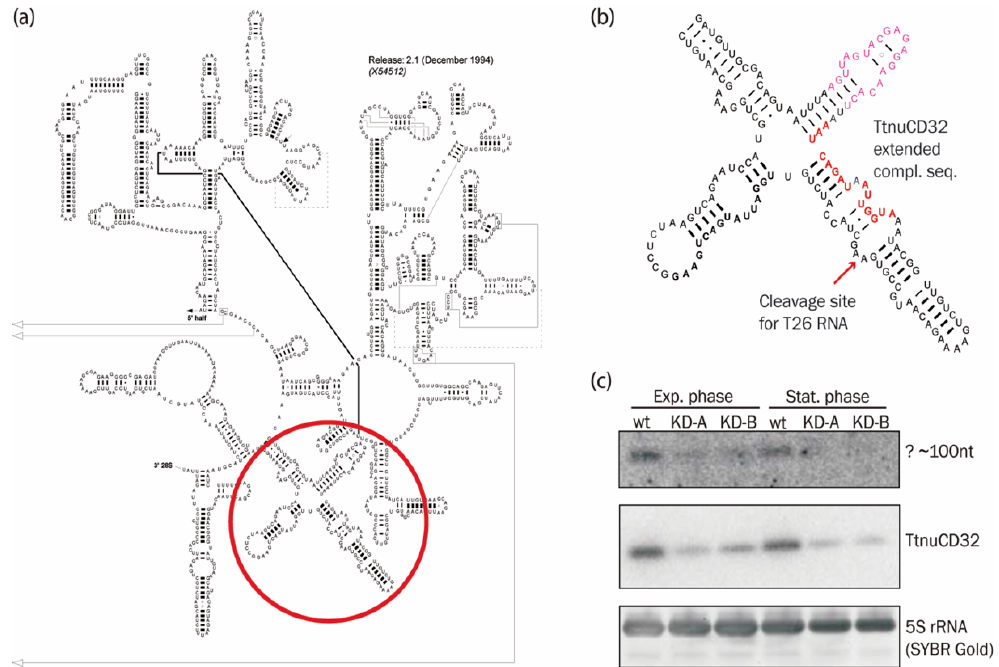
Figure 4. A small rRNA fragment derived from 26S rRNA in the vicinity of a putative non-canonical TtnuCD32 interaction site: ( a ) Secondary structure diagram of the 3 ′ end of Tetrahymena 26S rRNA. The structure was derived from the CRW web site (http://www.rna.ccbb.utexas.edu/) [47]. A red circle highlights position of the domain VI zoomed in on in ( b ); ( b ) Domain VI with the potential hybridization site of TtnuCD32 highlighted in red nucleotides, the sarcin-ricin stem-loop in purple and the sequence recognized by the probes used in ( c ) in bold letters. The 5 ′ end of the longest form of T26 RNA is marked by a red arrow; ( c ) Northern blot analysis of the 3 ′ end of 26S rRNA in RNA harvested from wt and two TtnuCD32 knock-down (KD) cell lines in exponential and stationary phase cells. Upper panel: An approximately 100 nt long RNA detected with a probe targeted against the 5 ′ end of T26 RNA (bold nucleotides in ( b )). The middle panel shows the knock-down level of TtnuCD32 and the lower panel a SYBR gold staining of 5.8S rRNA as a loading control.